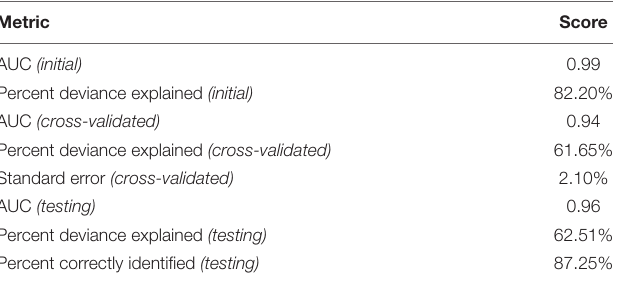
TABLE 2 | Model performance